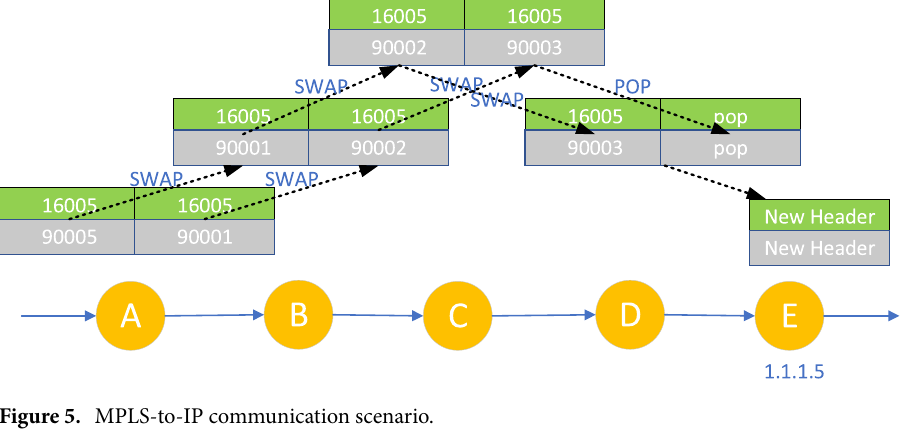
Figure 5. MPLS-to-IP communication